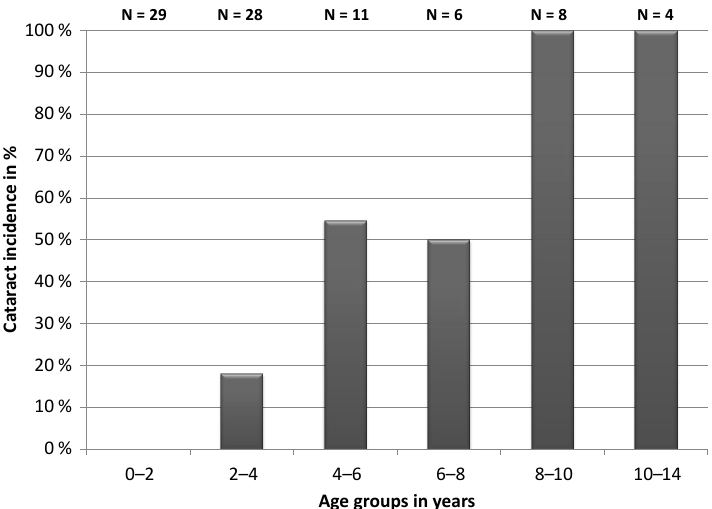
Figure 2. Incidence of cataracts in different age categories of mouse lemurs. N is the number of all investigated animals in this age group.